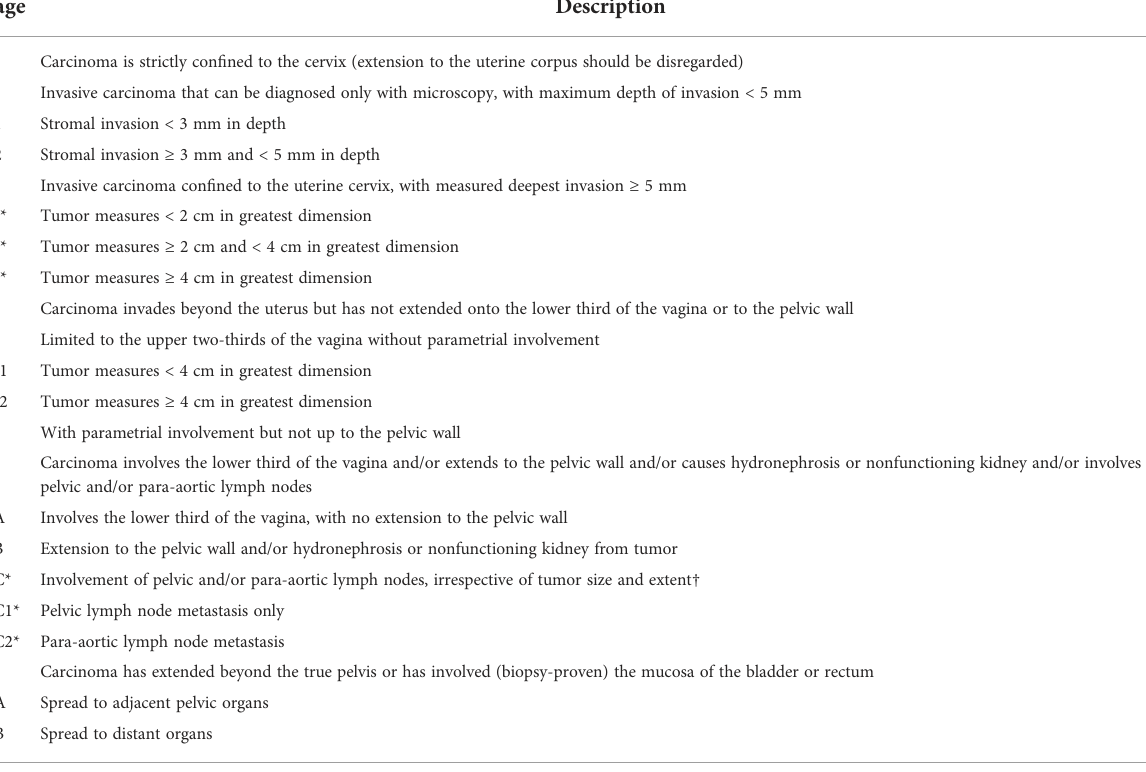
TABLE 1 2018 Federation International of Gynecology and Obstetrics (FIGO) Staging System for uterine cervical cancer. Stage